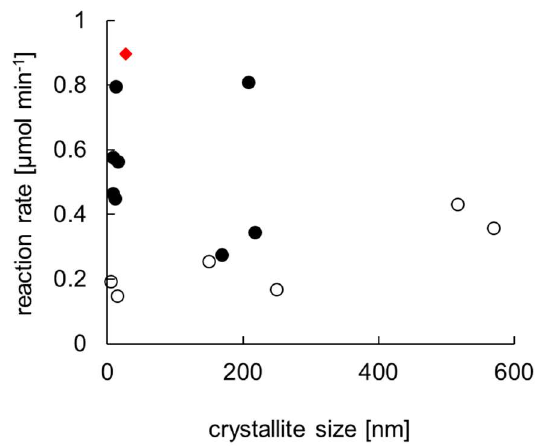
Figure 1. Photocatalytic activity of commercial titania samples for oxidative decomposition of acetic acid under UV/vis irradiation (Usually smaller crystallite size and anatase presence result in high photocatalytic activity.); P25—red rhombus ( ◆ ); anatase-rich samples—solid circles ( ● ); rutile-rich samples—empty circles ( ○) ; reaction rate—rate of CO 2 evolution.